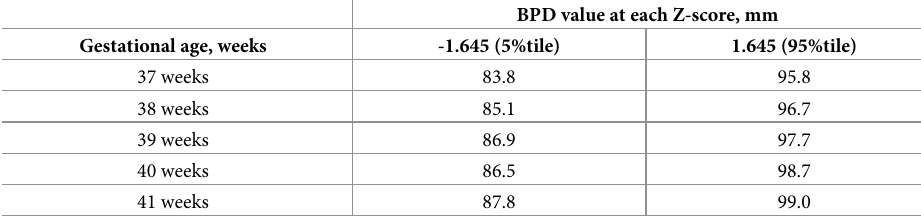
Table 1. Reference of BPD value based on Z-score (-1.645 = 5th and 1.645 = 95th) every gestational